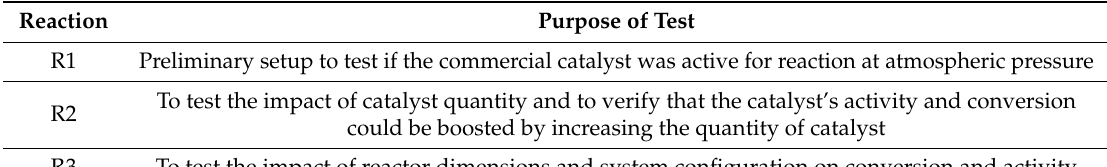
Table 1. Reaction process refinement tests.